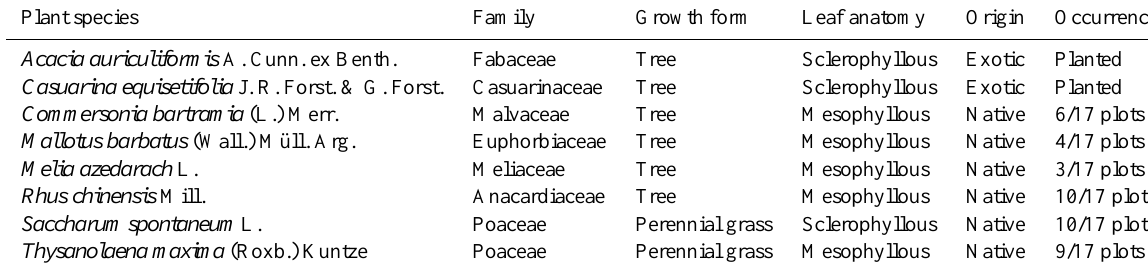
Table 1. Description of studied plant species and their surveyed natural occurrence in post-mining areas in north-eastern Vietnam (occurrence data base on Finkenbein et al., unpublished data). Plant species Acacia auriculiformis A. Cunn. ex Benth.